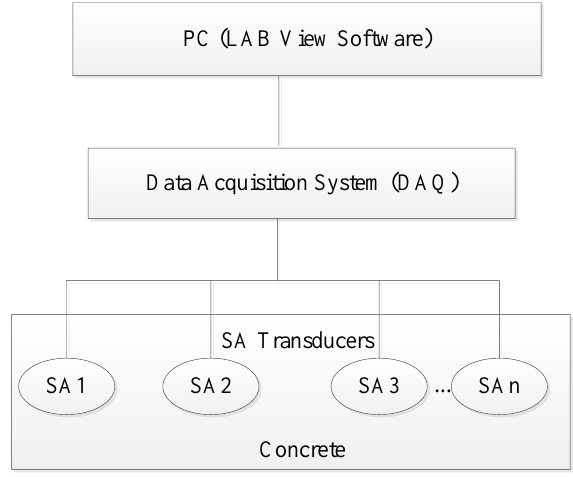
Figure 4. Measurement system.